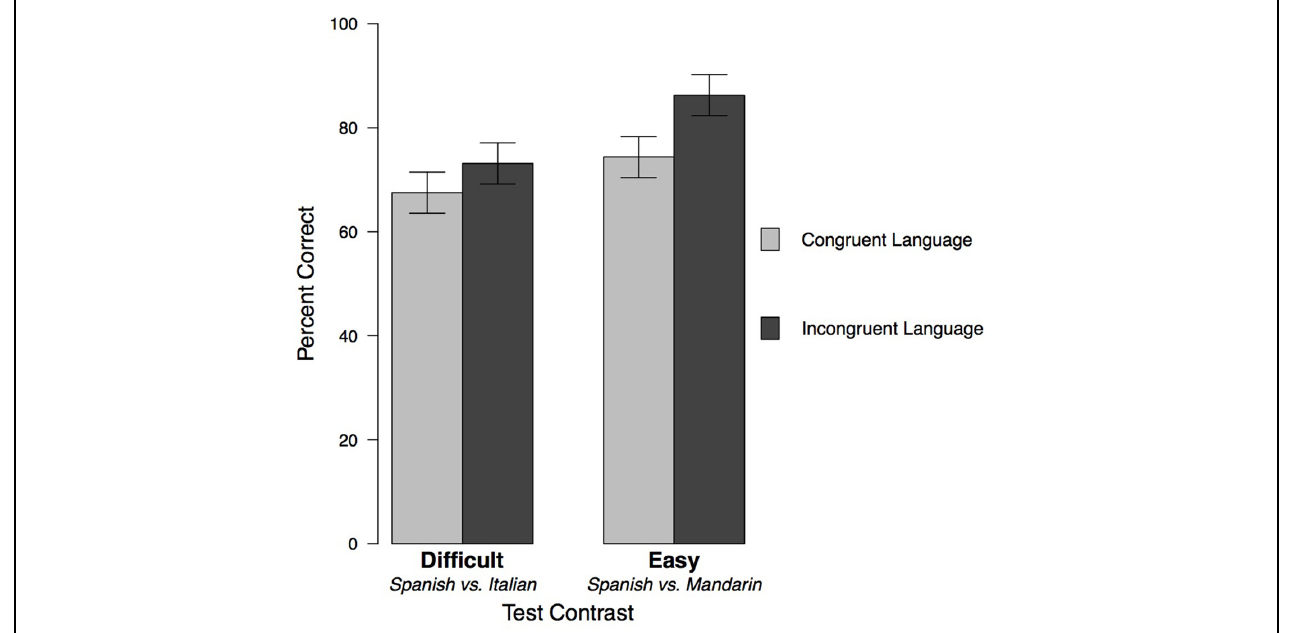
FIGURE 3 | Children’s performance on the discrimination task in Experiment 1 (Mandarin exposure) and Experiment 2 (Italian exposure), divided by the relation between Exposure Language and test materials. Error bars indicate standard errors.